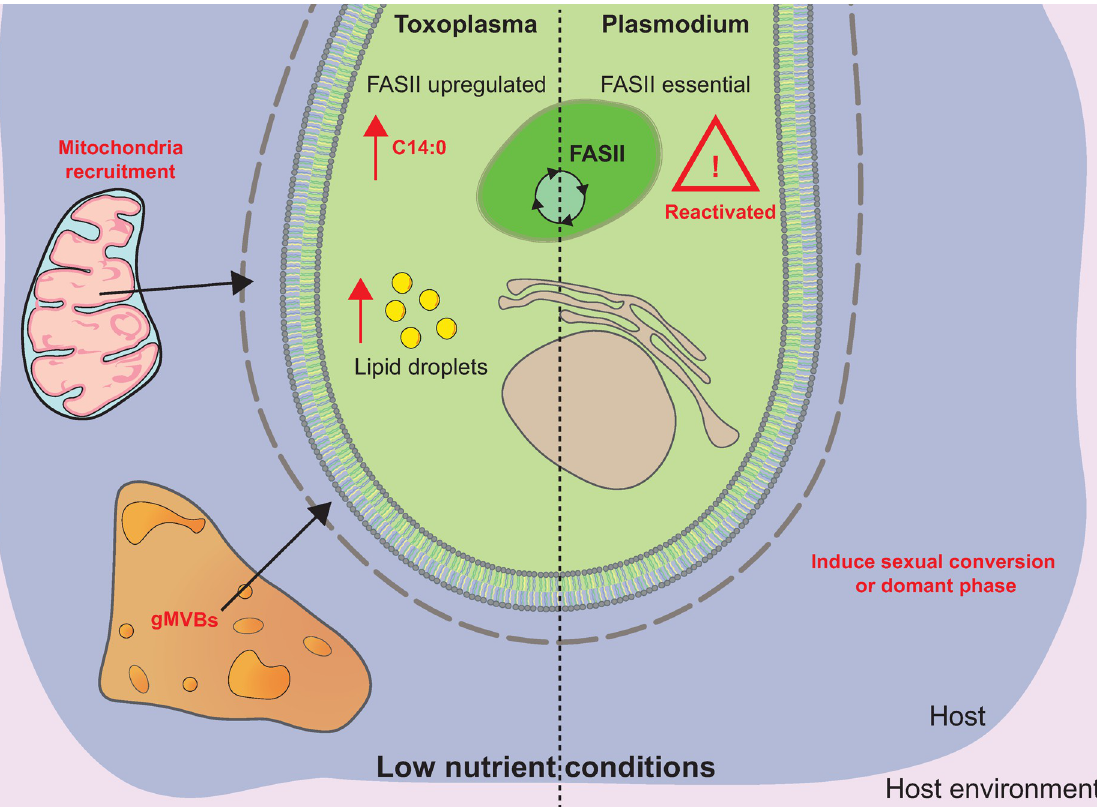
Fig 4. Cellular changes in parasite ( Toxoplasma : left; Plasmodium sp.: right) in low nutrient conditions. Mitochondria recruitment and gMVBs are apparent and exacerbated in low nutrient conditions of Toxoplasma tachyzoites. The metabolic up-regulation of FASII (resulting in the increase production of C14:0), along with an increase in parasite lipid droplets, is characteristic of low nutritional conditions in the host. In similar conditions, when nutrients are limited in the host environment, Plasmodium falciparum asexual blood stages can up-regulate the metabolic activity of the apicoplast FASII, rendering it essential in these conditions. The lack of LPC in the host environment leads to sexual conversion of the parasite. Very little is known about the adaptation of this parasite to changing lipid statuses. gMVB, giant multivesicular body; LPC,